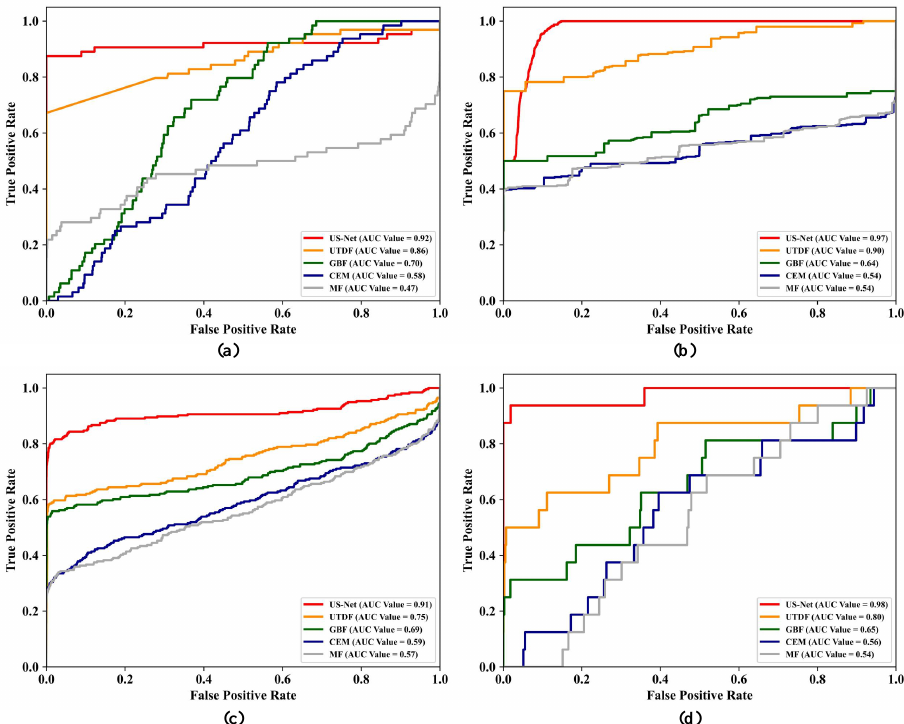
Figure 12. The ROC curves of ( P D , P F ) for the compared underwater target detection methods on a